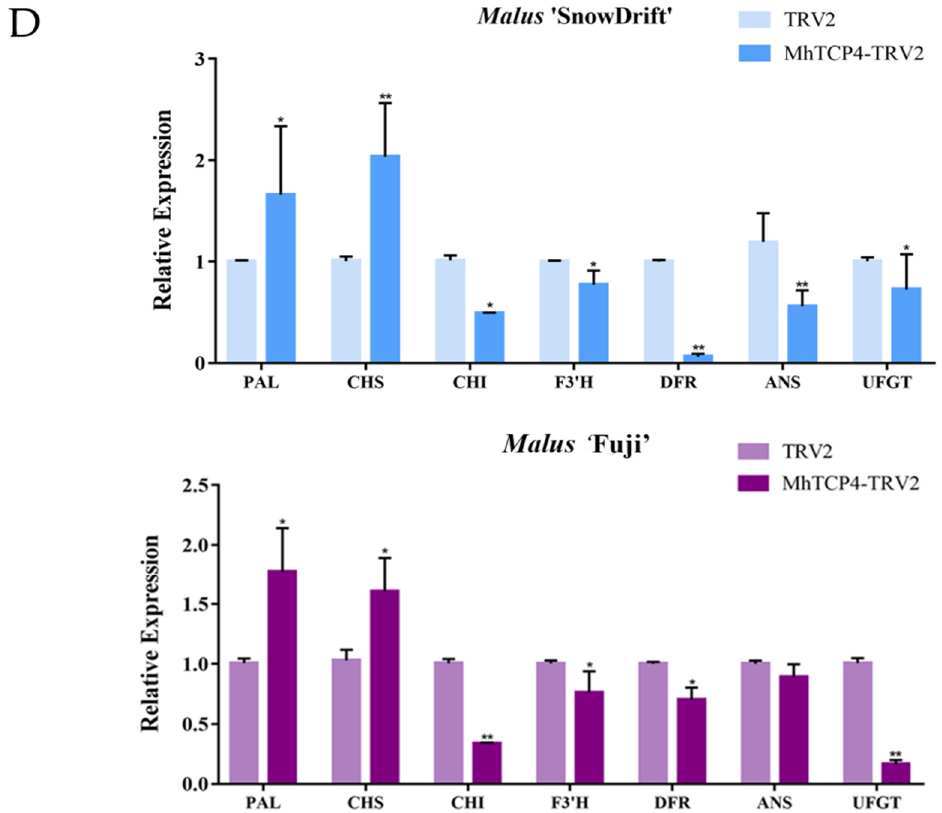
Figure 6. Transient silence of MhTCP4 in fruit peels of Malus ‘Snowdrift’ and Malus ‘Fuji’. ( A ) Fruit peel coloration around injection sites. MhTCP4-pTRV2 were used for overexpression with the pTRV2 vector. Empty vectors were the control. ( B ) The cyanidin 3-galactoside content of transgenic and control fruit peels. ( C ) The expression levels of MhTCP4 in MhTCP4 -silence and control fruit peels. ( D ) The expression levels of anthocyanins biosynthesis genes in MhTCP4 -silence and control fruit peels. Error bars represent the SEs of three biological replicates and three technical replicates. * p < 0.05, ** p < 0.01 using the t